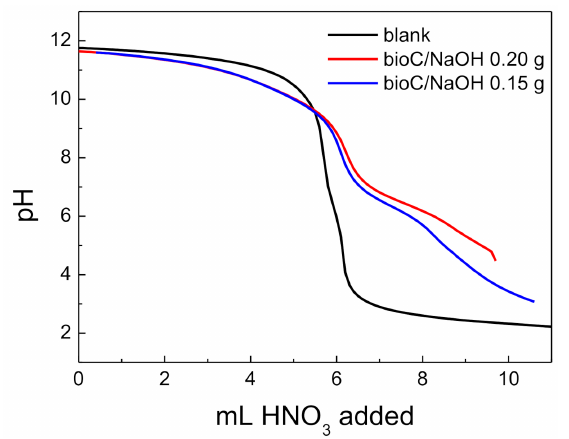
Figure 7. Titration curves for the blank solution and two suspensions of biochar with 0.15 and 0.20 g.